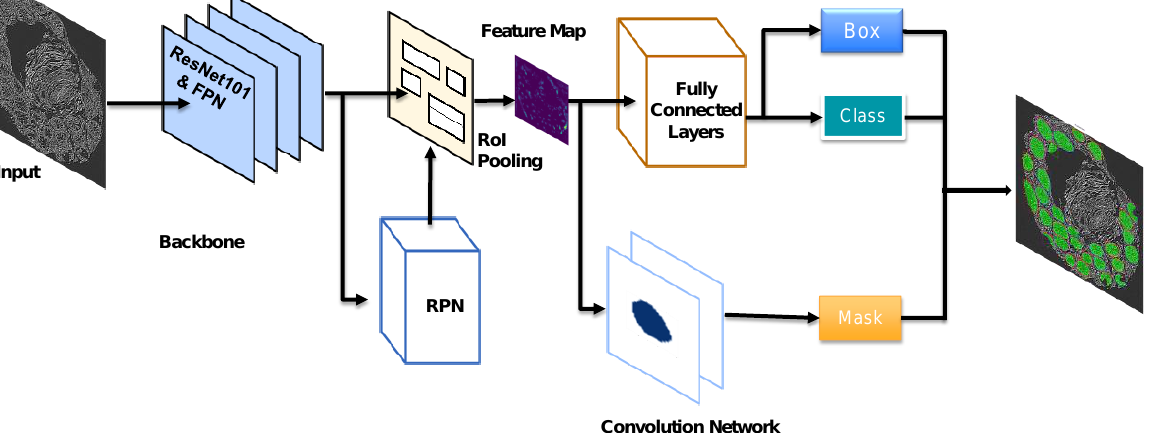
Figure 2. The mask R-CNN network architecture. The mask R-CNN (regional convolutional neural network) framework contains two stages: scanning images and generating regional proposals for possible objects; and classifying the proposals and generating bounding boxes and pixel-wise masks. This specific network adopts the backbone of ResNet101 plus FPN for feature extraction. The RPN (region proposal network) scans over backbone feature maps, which allows extracted features to be reused, and removes duplicate calculations. The RPN outputs two results for each anchor: anchor class (foreground or background: foreground implies the potential existence of an object) and bounding box refinement (the foreground anchor box, with its location and size, is refined to fit the object). The final proposals are passed to the next stage. At this stage, two outputs are generated for each ROI as proposed by the RPN: class (for objects) and bounding box refinement. An ROI pooling algorithm crops a piece of area from a feature map and resizes it to a fixed size, which enables the functionality of classifiers. From this stage, a parallel branch of two fully convoluted layers is added that generates masks for the positive regions that are selected by the ROI classifier. The other branch of fully connected layers takes the outputs of the ROI pooling and outputs two values: a class label and a bounding box prediction for each